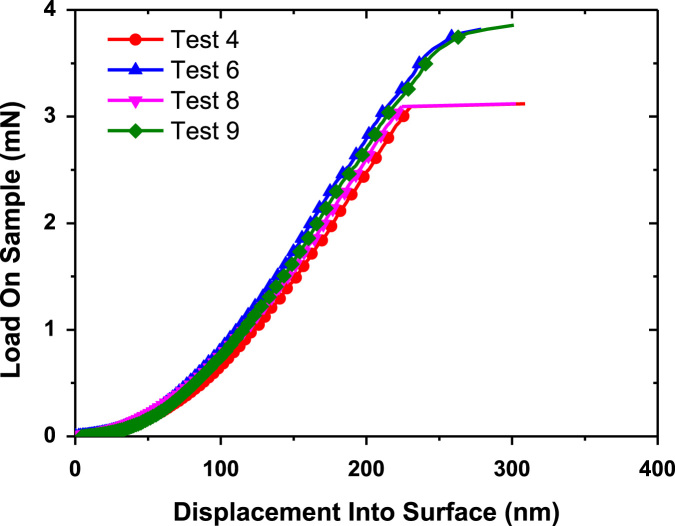
Representative Load displacement curves of LixMn2O4 cathode material.